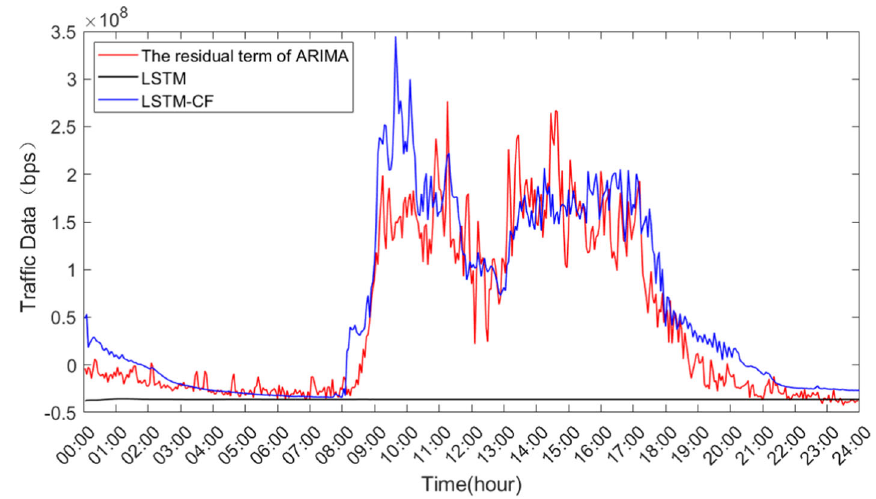
Fig. 10 The prediction residual term is based on LSTM-CF and LSTM